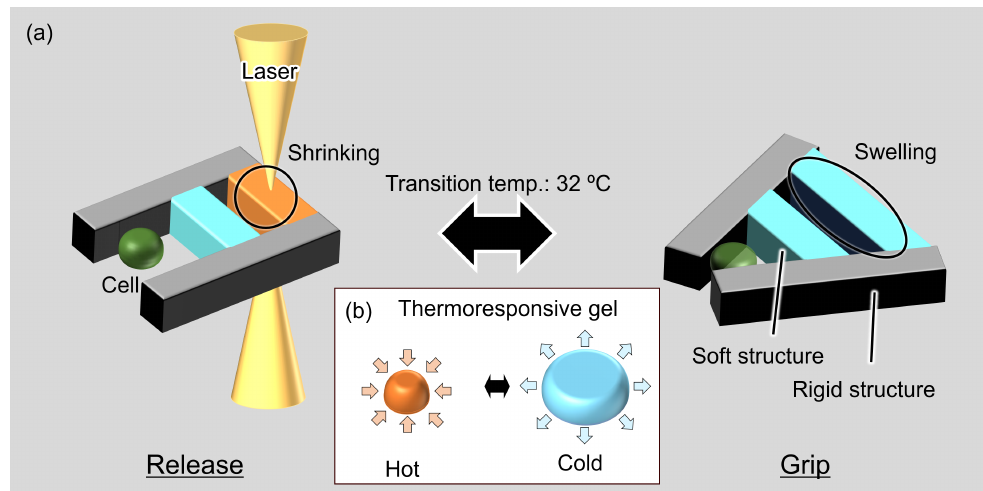
Figure 1. Concept of the proposed microgripper using thermoresponsive gel actuators: ( a ) gripping and driving of the microgripper; and ( b ) the volume change of a thermoresponsive gel as a soft actuator.